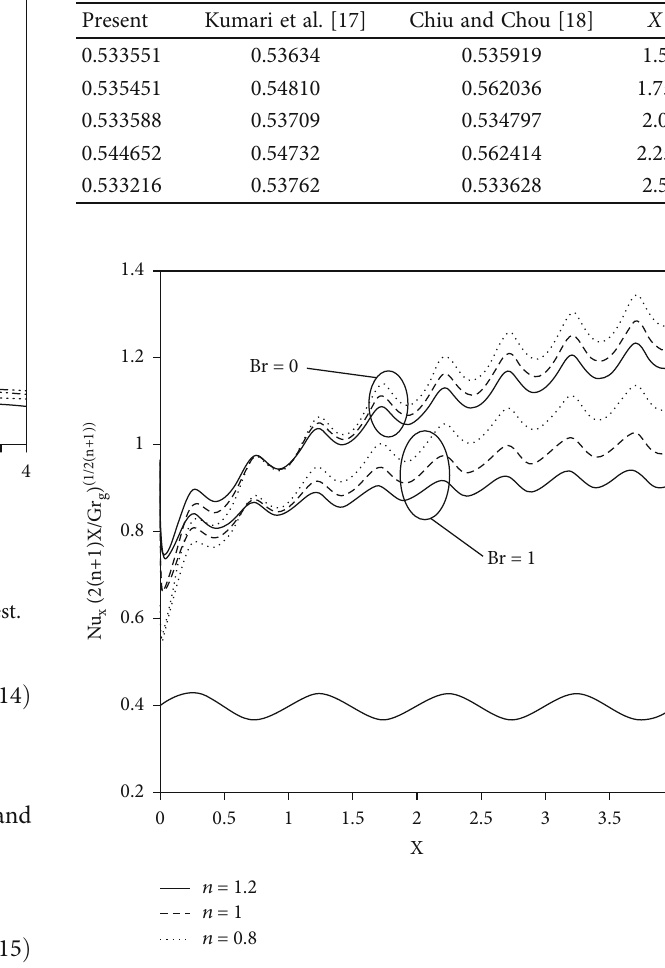
Table 1: Comparison of the Nusselt number as Nu